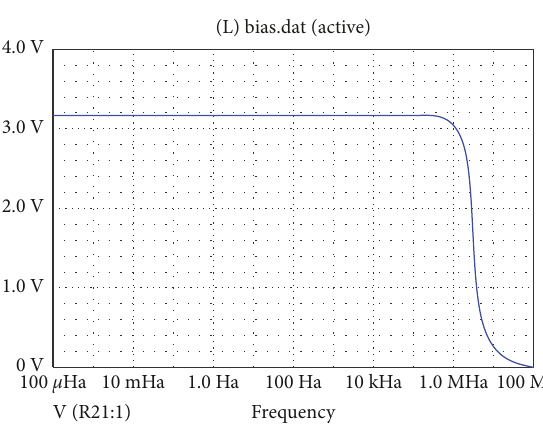
Figure 6: PSpice diagram of the frequency response of the antialiasing filter.